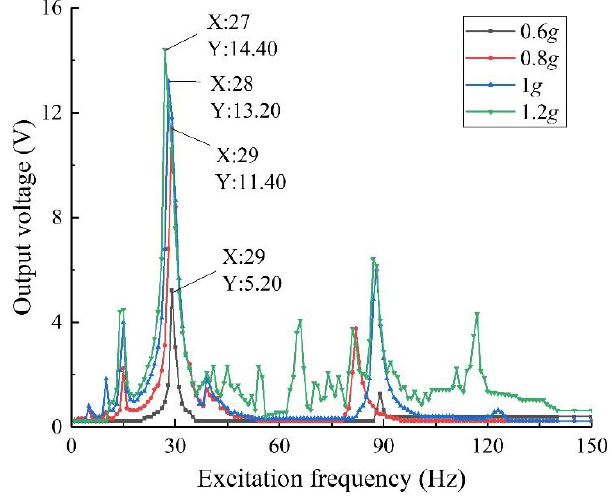
Figure 13. Output voltage under different excitation